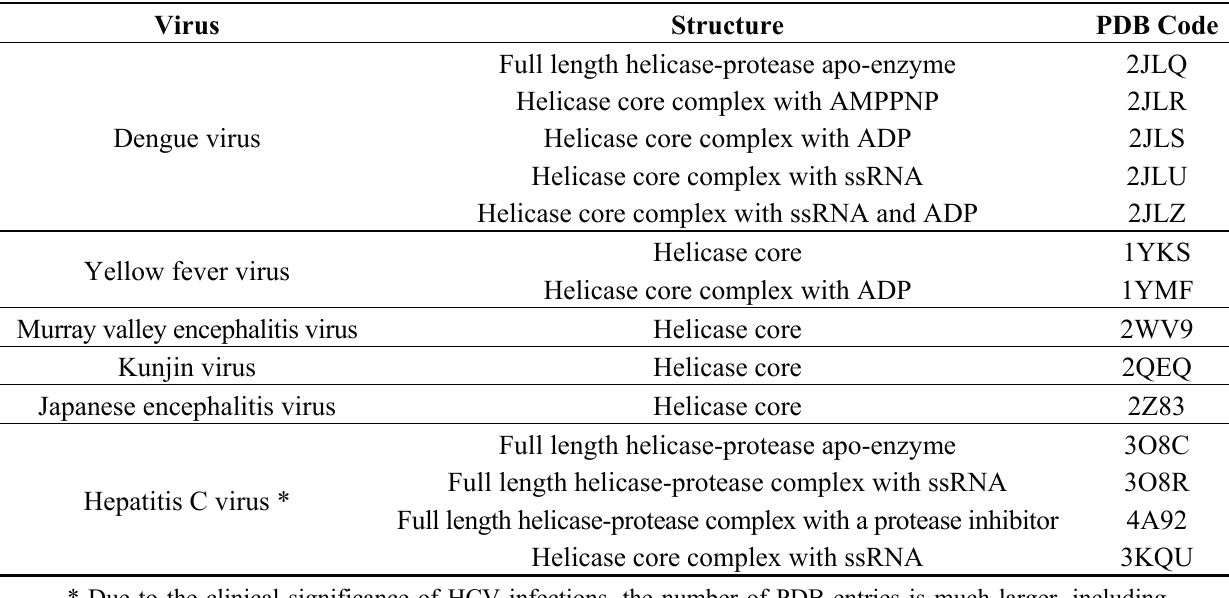
Table 1. Representative structures of NS3 helicases from elements belonging to the Flaviviridae family of